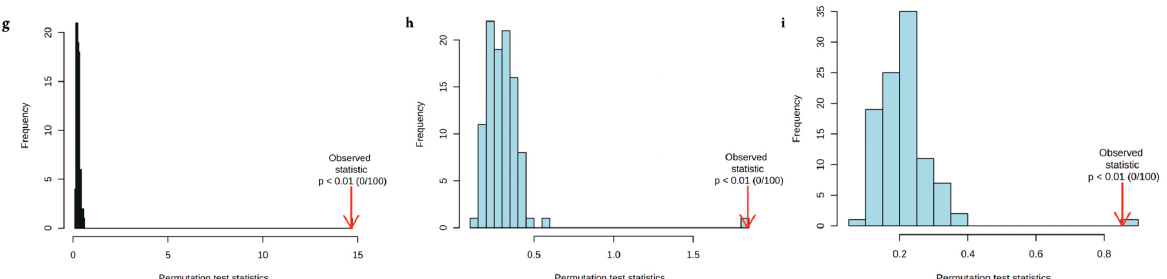
Figure 4. Differential metabolic features of urine between groups pooled by risk factor using partial least squares discriminant analysis (PLS-DA). Two-dimensional visualization of separation of groups by PLS-DA is shown in ( a ) individuals living in Nicaragua (Nica) vs. Spain, ( b ) individuals working in high- vs. low-intensity manual labor jobs, and ( c ) individuals working in agriculture (Ag) vs. not in agriculture (NotAg). Important features by variable importance in prognosis (VIP) score in PLS-DA are shown for ( d ) Nicaragua vs. Spain, ( e ) high- vs. low-intensity labor, and ( f ) agriculture vs. not in agriculture. Permutation test validation based on separation distance is shown for PLS-DA models for ( g ) Nicaragua vs. Spain, ( h ) high- vs. low-intensity labor, and ( i ) agriculture vs. not in agriculture. 1MG, 1, methylguanidine; GAA, guanidinoacetic acid; 2FG, 2-furoylglycine; MMA, methylmalonic acid; PAA, phenylacetic acid; MNA, 1-methylnicotinamide; 2oxoIVA, 2-oxoisovaleric acid; NAG, N-acetylglutamate; 4-HHA, 4-hydroxyhippuric acid; 1MG, 1-methylguanidine; 3MG, 3-methylglutaconic acid.